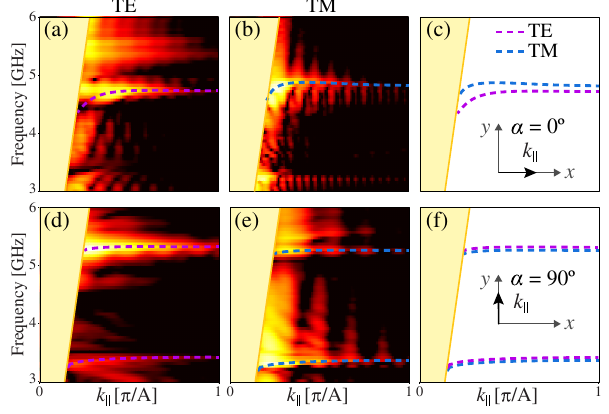
FIG. 10. Reconstructed dispersion of surface waves excited by magnetic (a,d) and electric (b,e) sources propagating along (a,b) and across (d,e) the strips. We show the comparison of the reconstructed dispersion for TE and TM surface plasmons along (c) and across (f) the